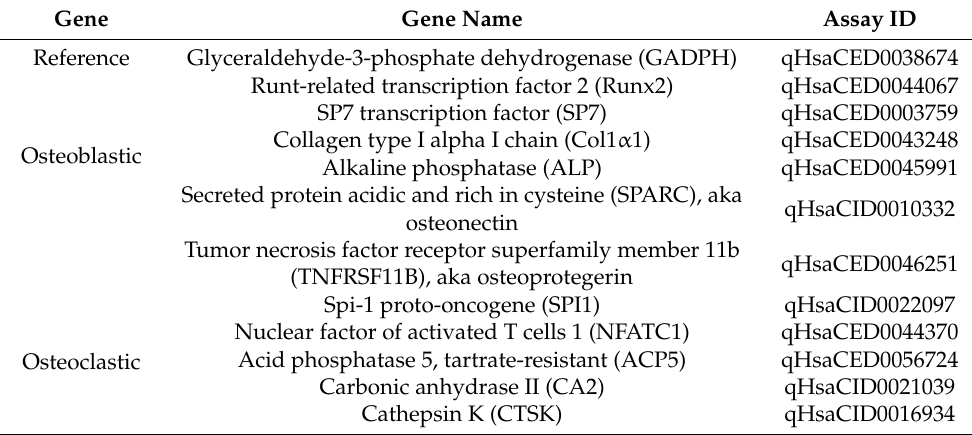
Table 1. Genes and respective primers assay ID (BioRad) for